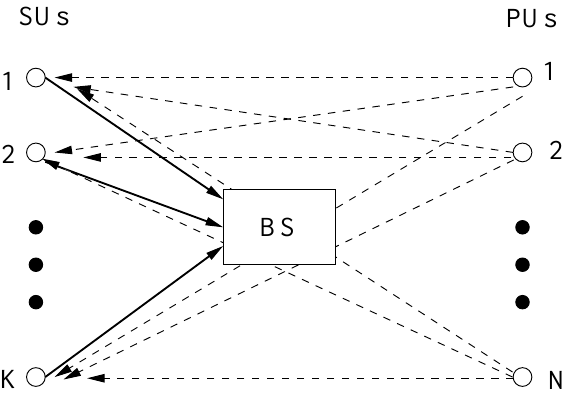
Figure 2. SUs to BS and signals from primary users (PUs) as the interference.